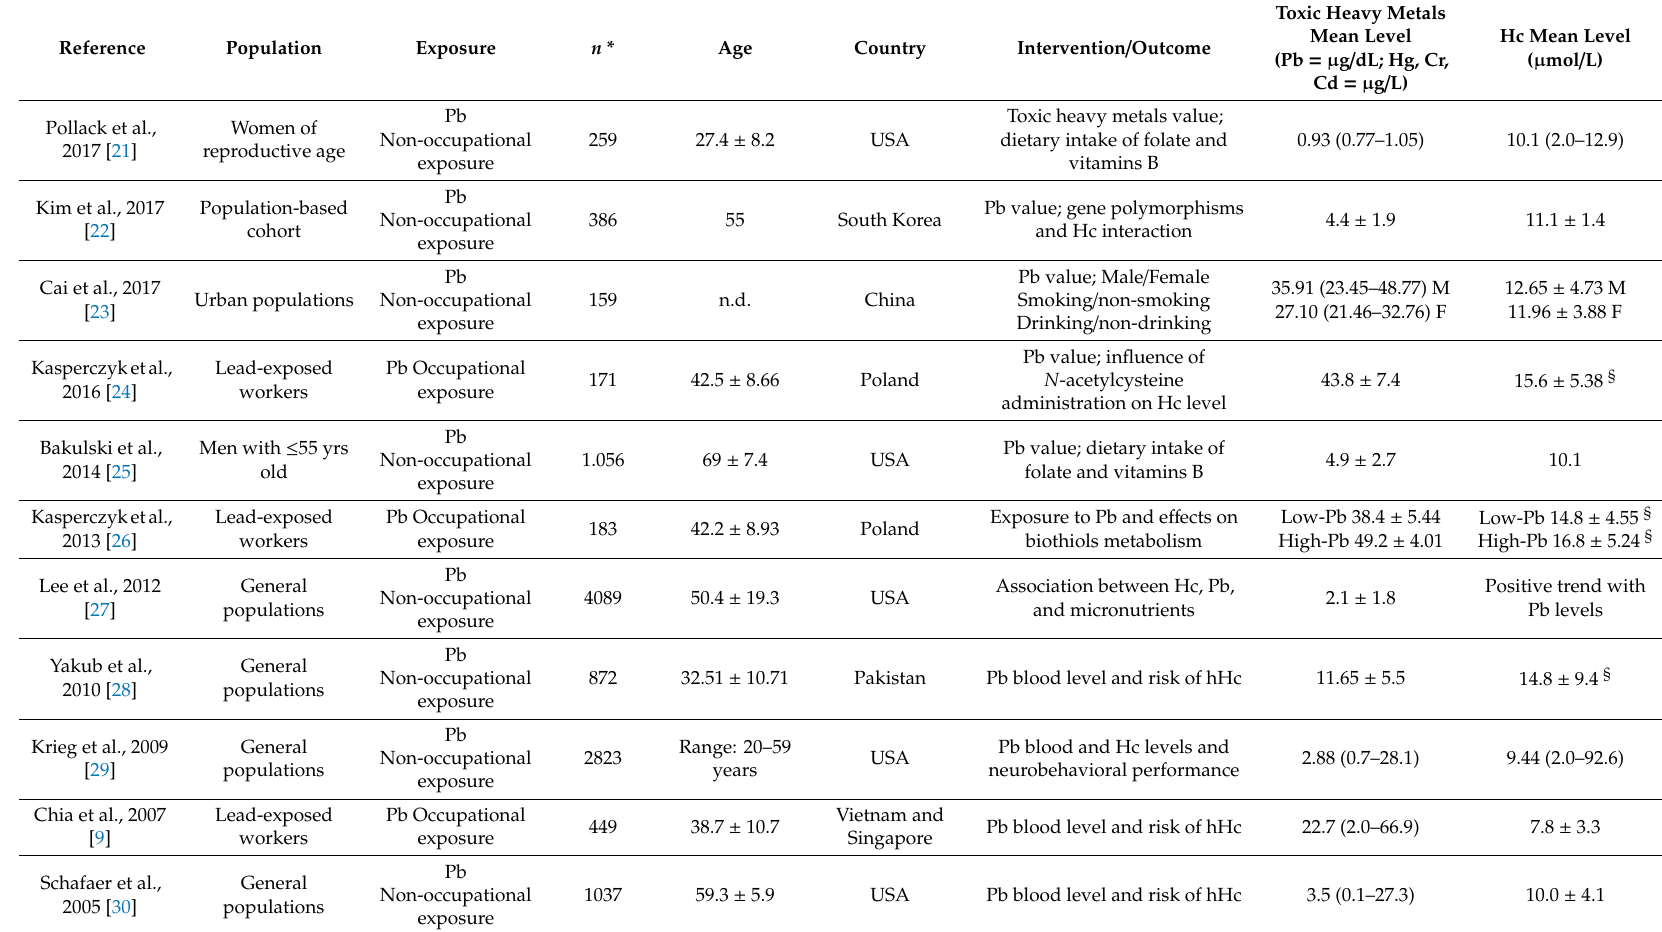
Table 1. Characteristics of eligible